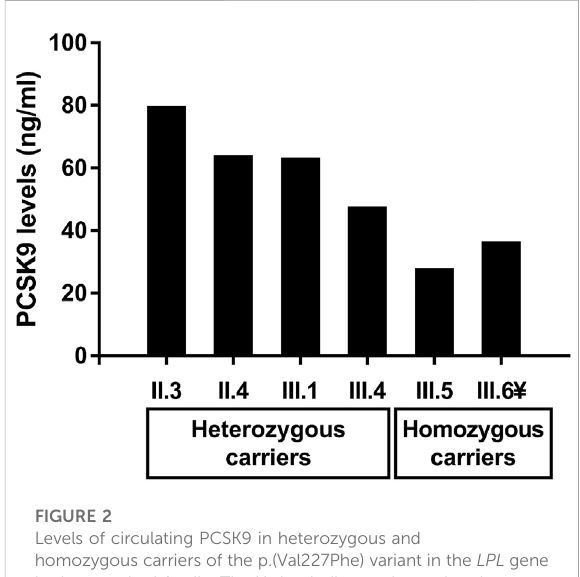
FIGURE 2 Levels of circulating PCSK9 in heterozygous and homozygous carriers of the p.(Val227Phe) variant in the LPL gene in the recruited family. The ¥ sign indicates the